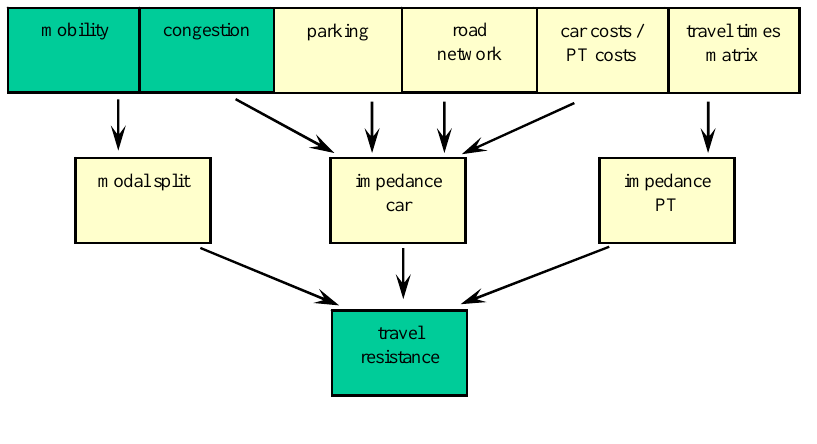
Figure 6. Travel impedance